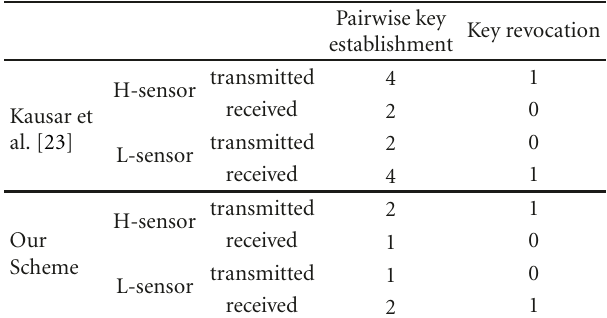
Table 2: Number of messages for compared methods. Pairwise key